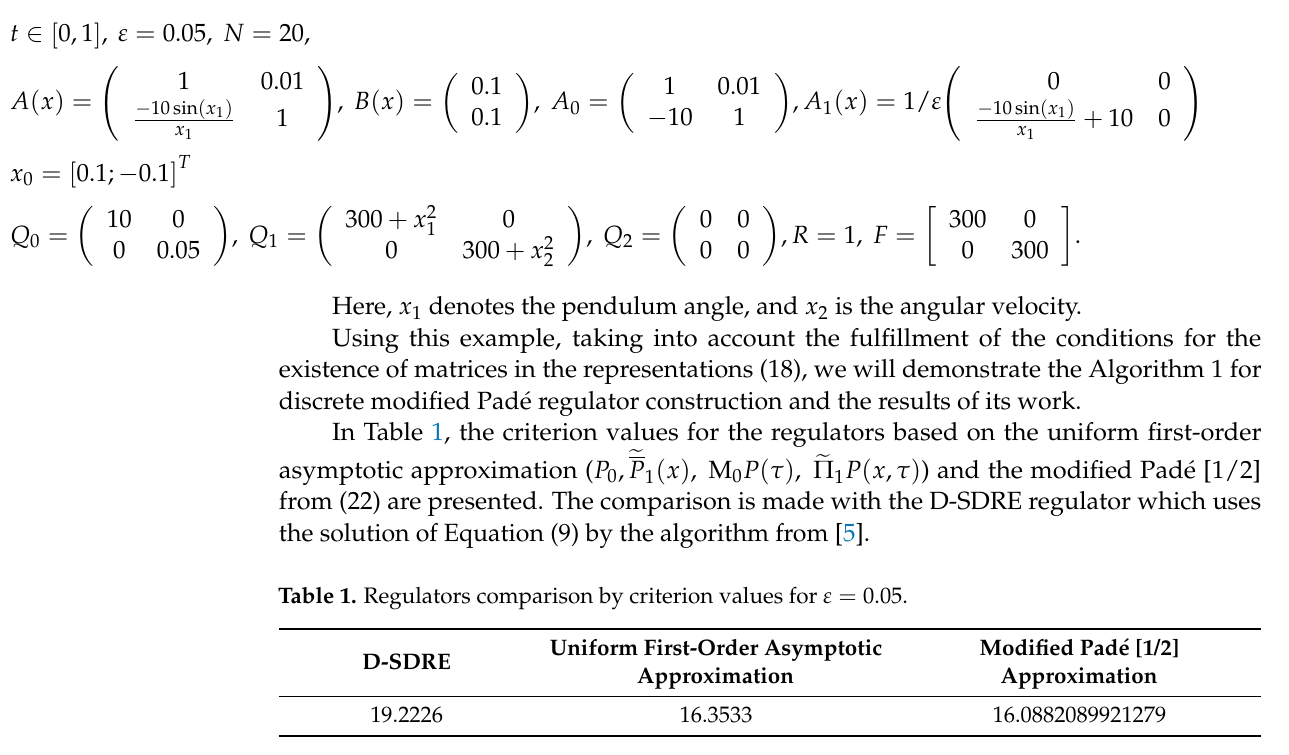
Modified Pad é [1/2] Approximation